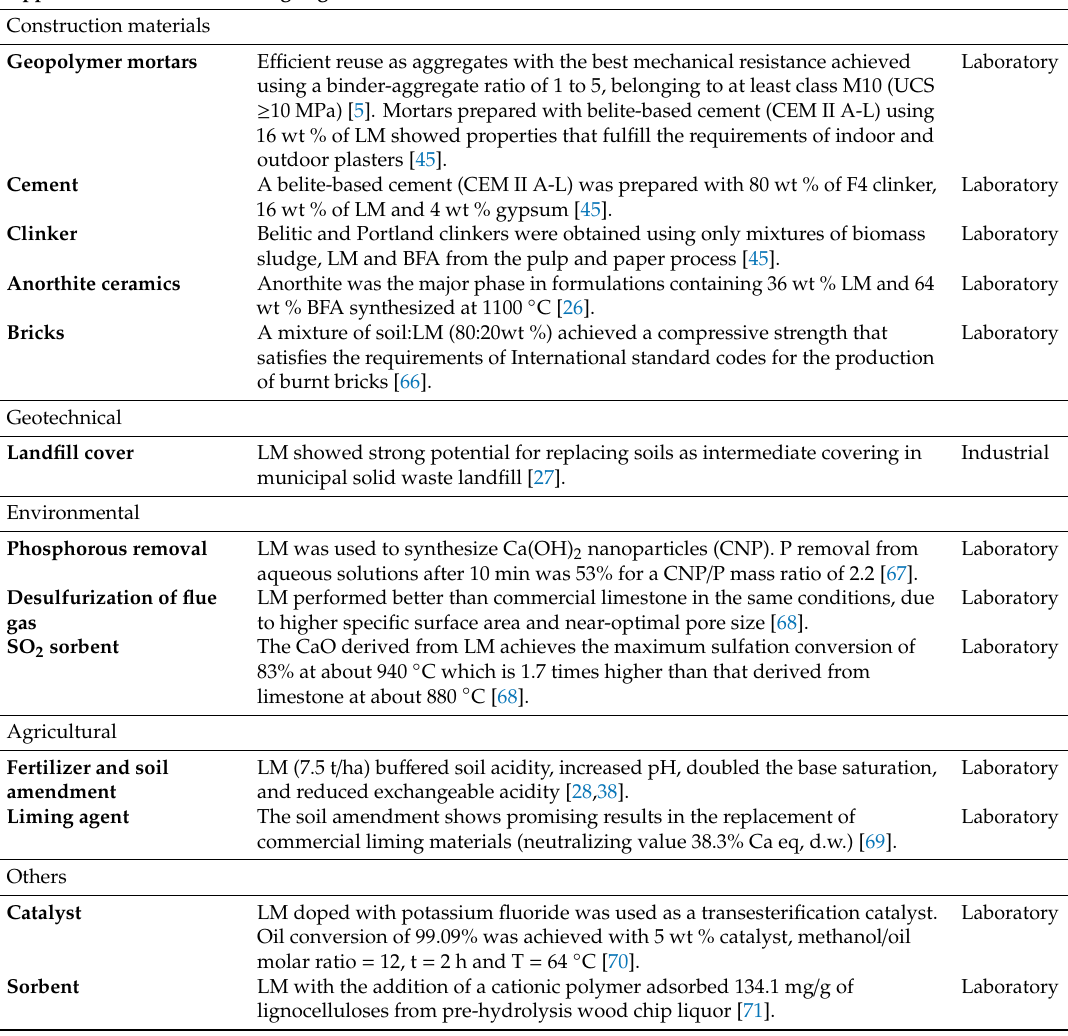
Table 8. Applications of LM reported in the